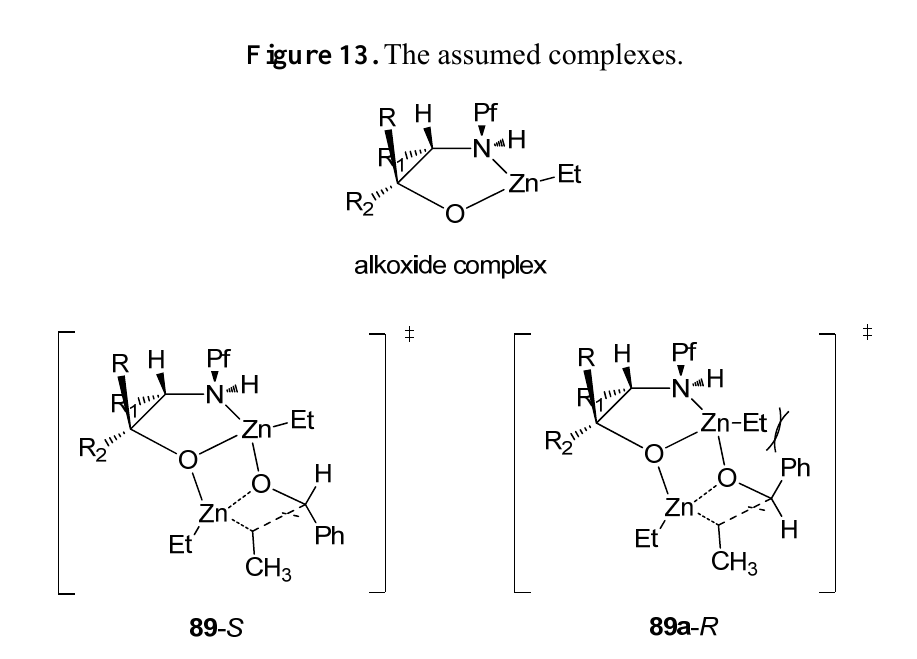
Figure 13. The assumed